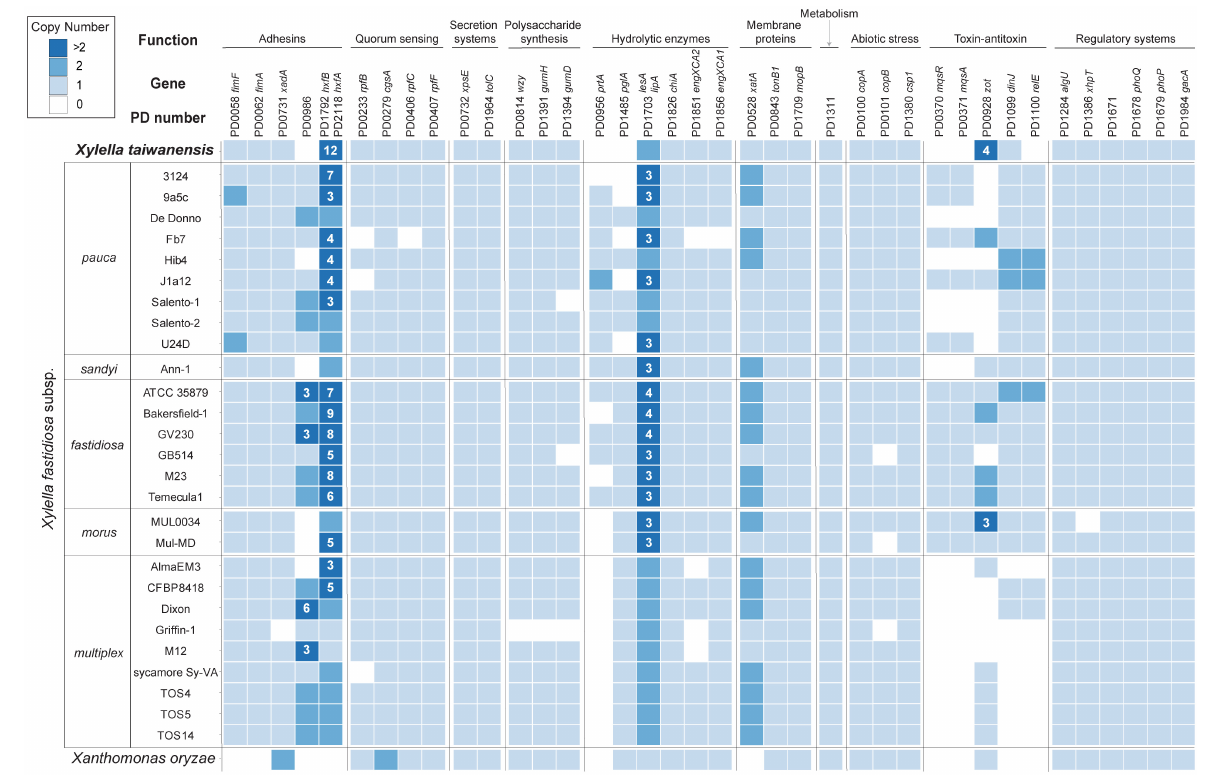
FIGURE 5 | Distribution of putative virulence genes and pathogenicity factors among representative Xylella genomes. Xanthomonas oryzae was included as the outgroup. The homologous gene clusters were identified by the PD numbers based on the annotation of Temecula1 genome; gene names were provided when available. Gene copy numbers were illustrated in the format of a heatmap; values higher than two were labeled with the exact numbers. Two adhesin genes (i.e., PD1792 and PD2118) were assigned to the same homologous gene cluster and were combined for copy number